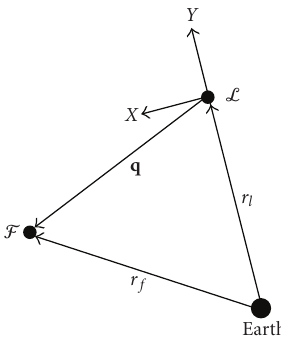
Figure 1: Relative motion of spacecraft and the earth.